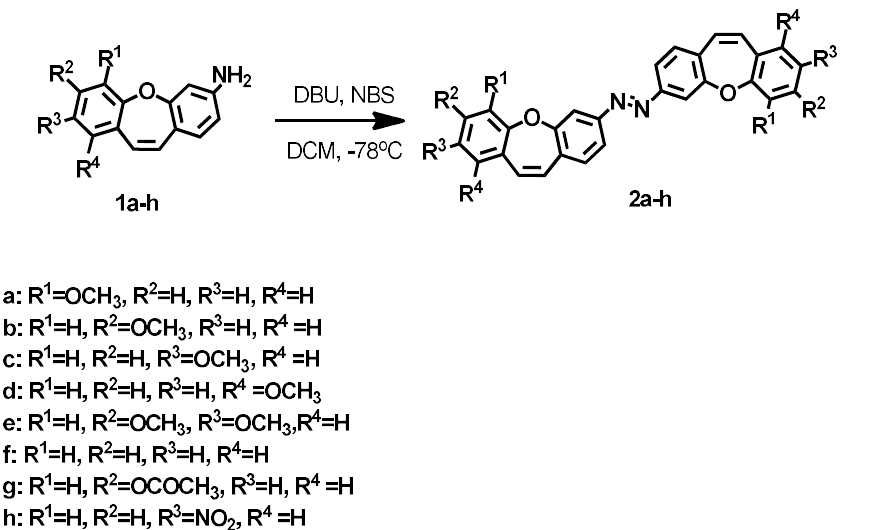
Table 1. Estimated binding free energy ( kJ/mol ) of 2a–2c and 2e–2f , isomers E and Z .